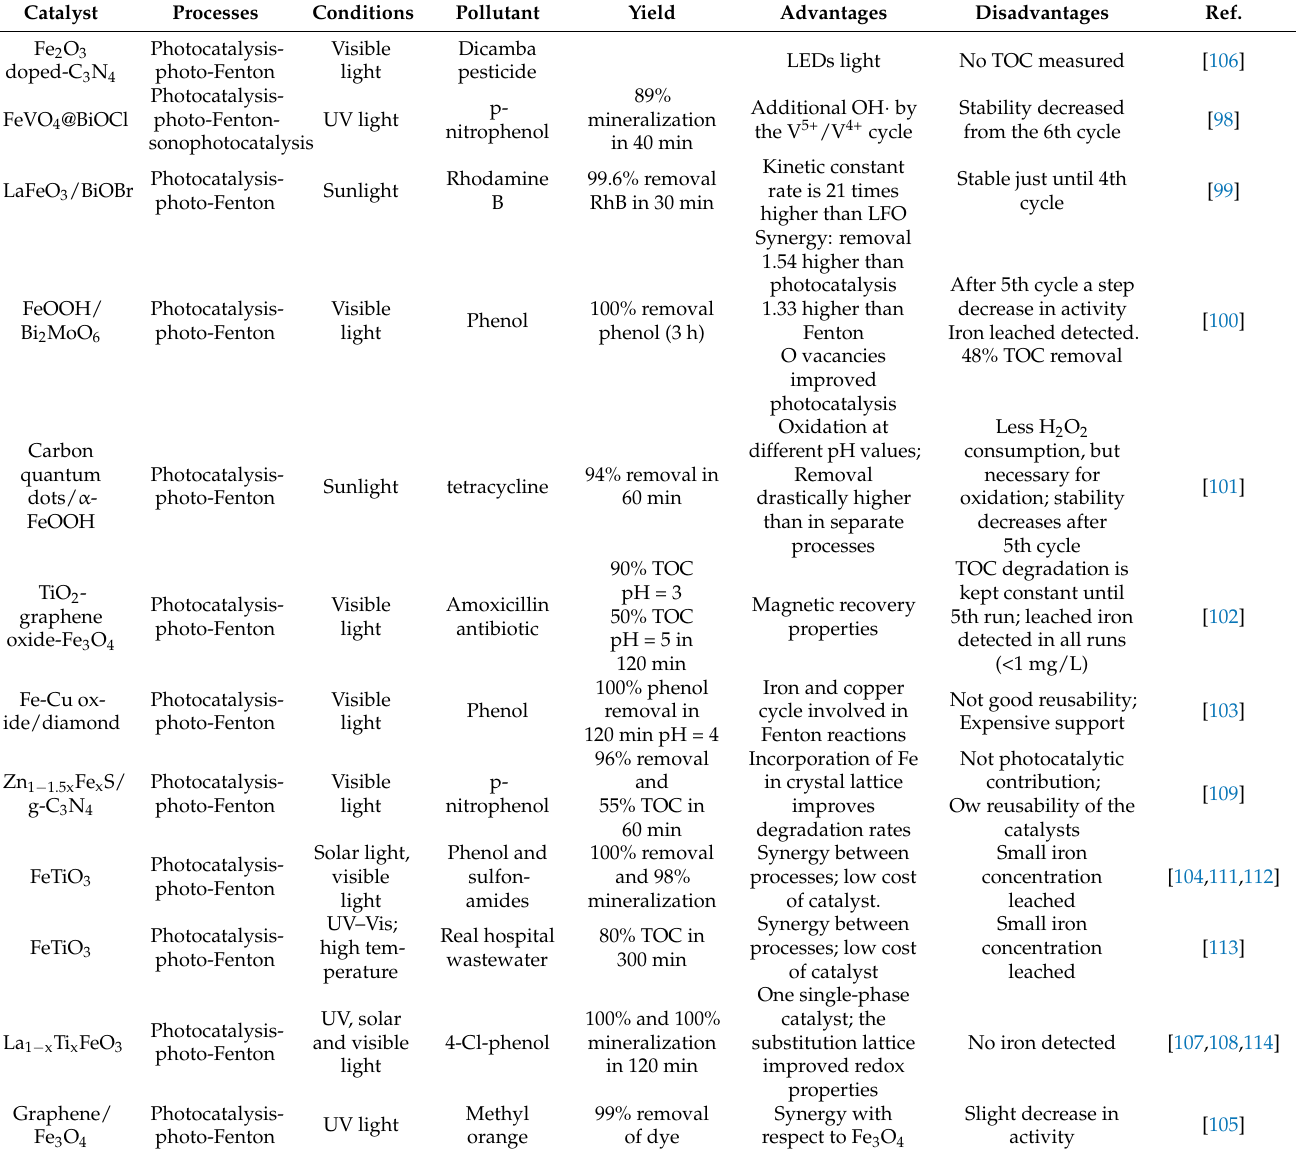
Table 7. Catalysts devoted to the combined photocatalytic-photo-Fenton processes.